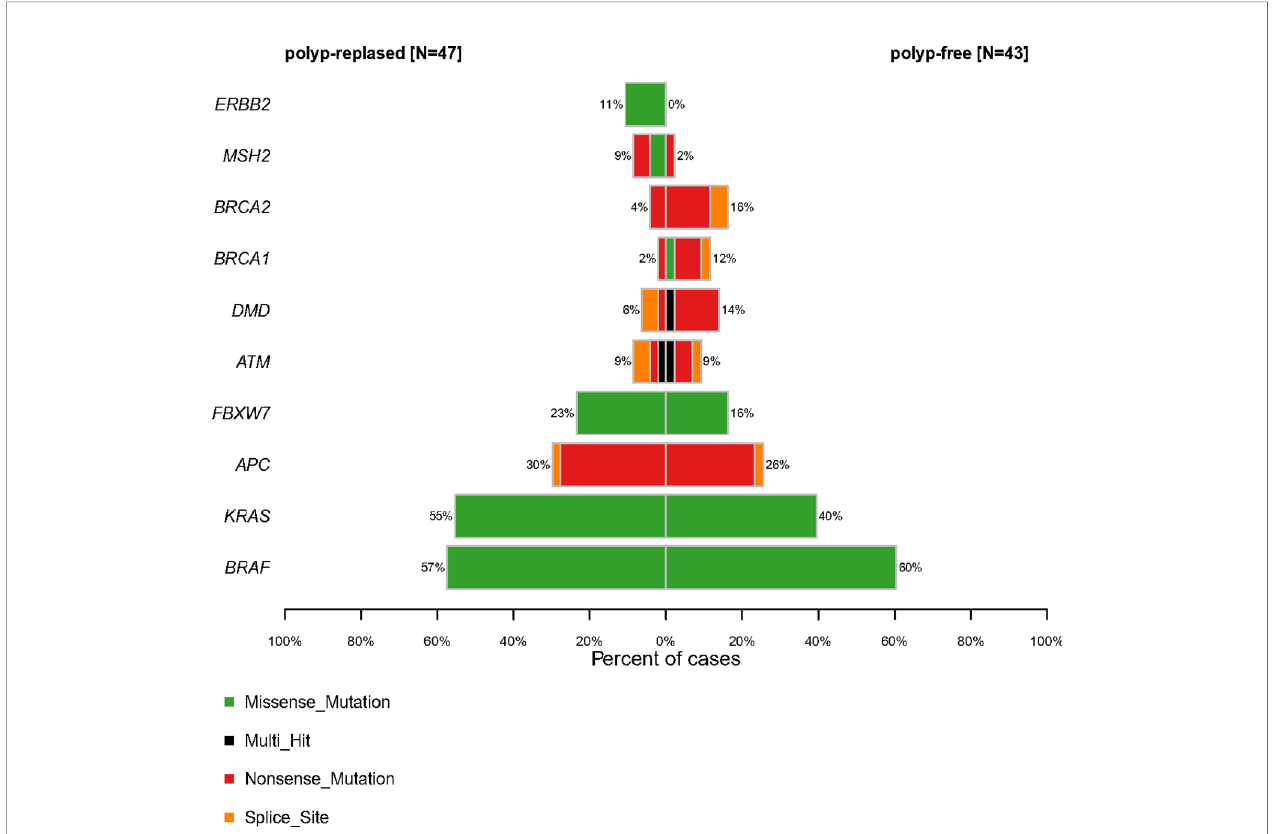
FIGURE 3 | Comparative pro fi les of top 10 genomic alterations in polyp-relapsed and polyp-free colorectal serrated polyps.